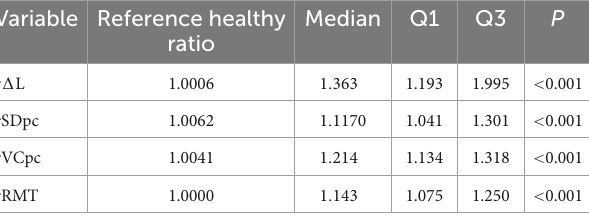
TABLE 2 Evaluation of significance and distribution of r (cid:49) L, rSDpc, rVCpc, and rRMT related to the control